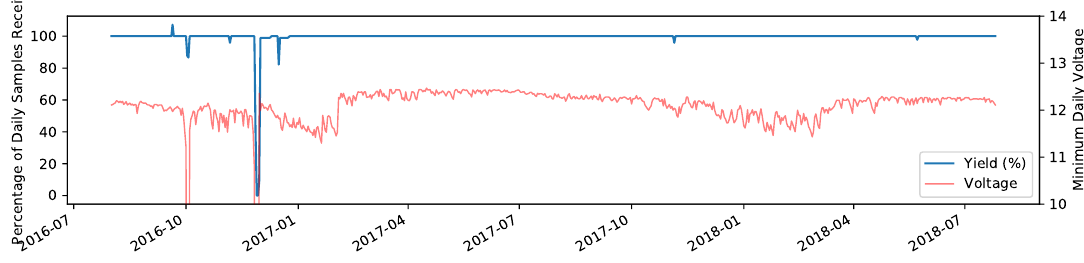
Figure 11. Raw data yield per day at the database and minimum battery voltage (to show battery failure) from August 2016 through July